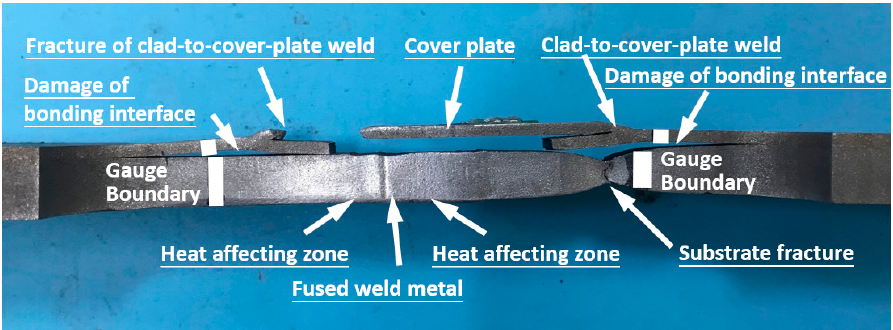
Figure 12. Failure mode of type III TC bimetallic steel butt-welded joints.